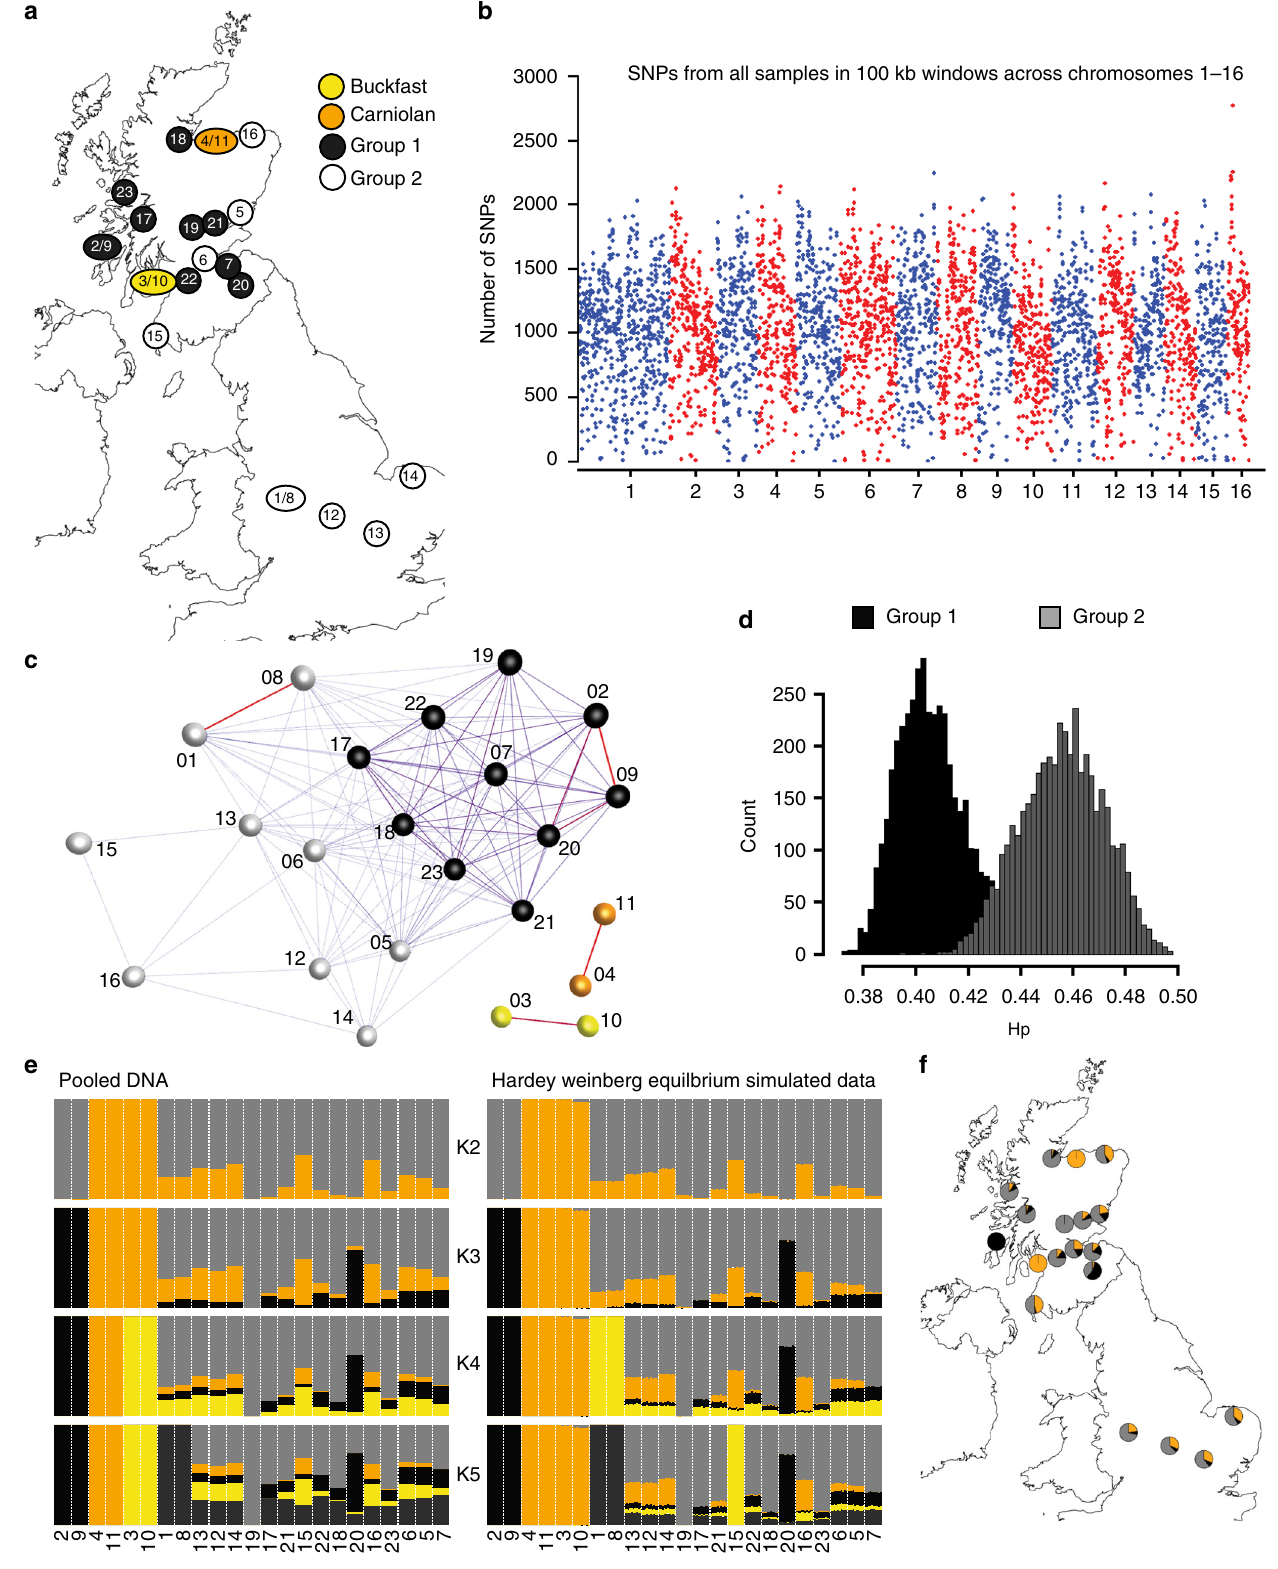
the Illumina HiSeq 2500, equivalent to between 17- and 50-fold coverage of the honey bee genome (Amel 4.5). were mapped onto the honey bee reference genome (version Amel